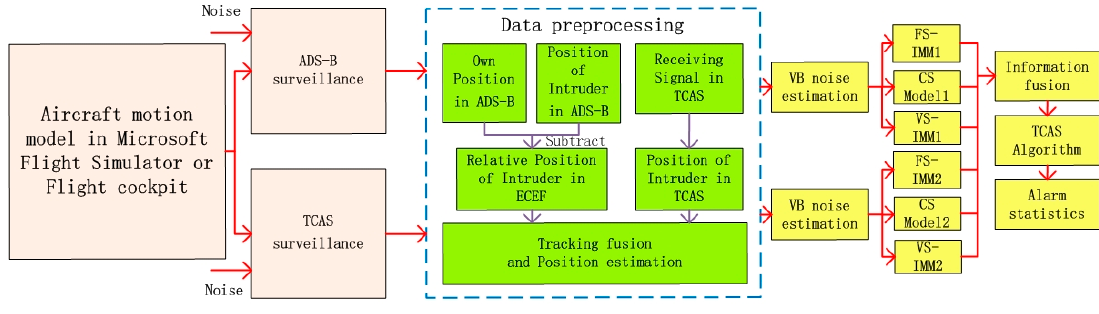
Figure 3. System frame diagram.